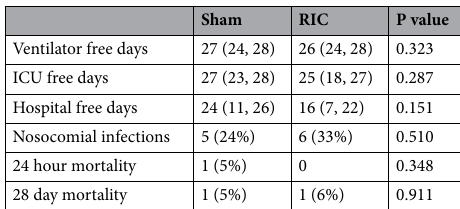
Table 2. Patient clinical outcomes. Values represent median (interquartile range) or number (percentile).